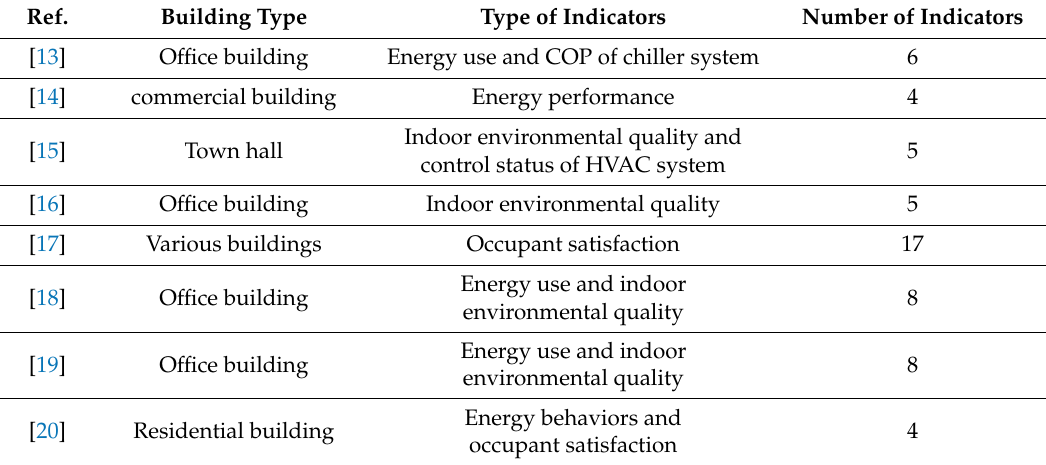
Table 2. The summary of type and number of indicators utilized by typical studies to evaluate the operational performance of green